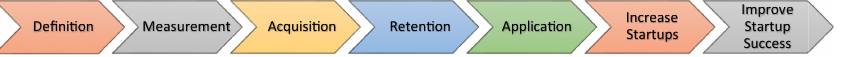
Figure 1. The competency-based causal